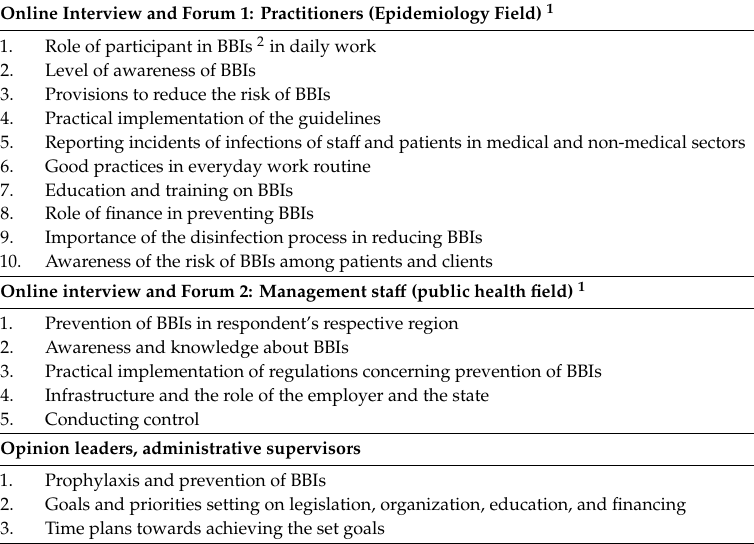
Table 2. Topic guide used with specific participant